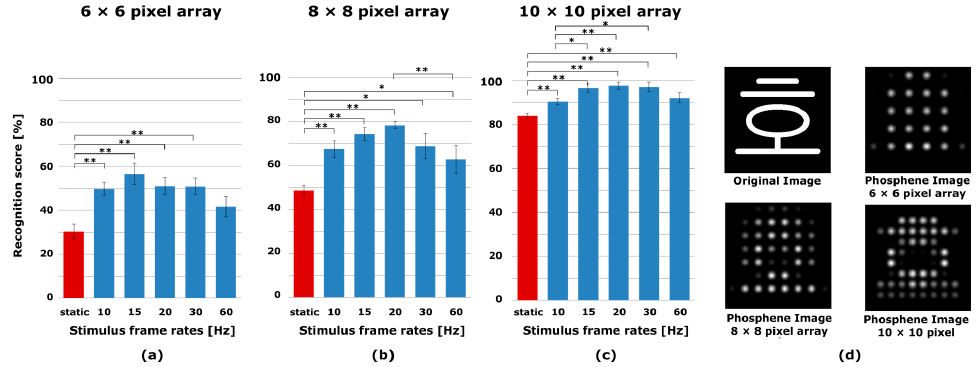
Figure 3. The recognition scores of Korean characters for 6 × 6, 8 × 8 and 10 × 10 pixel arrays and the example of original and phosphene images. The spatiotemporal pixelization method (blue) was compared with the static pixelization method (red). The result of recognition score with ( a ) 6 × 6 pixel array; ( b ) 8 × 8 pixel array and ( c ) 10 × 10 pixel array; ( d ) The example of original and phosphene images. Error bars indicate SEM. One-way ANOVA and Tukey post-hoc test, * p < 0.05, ** p <